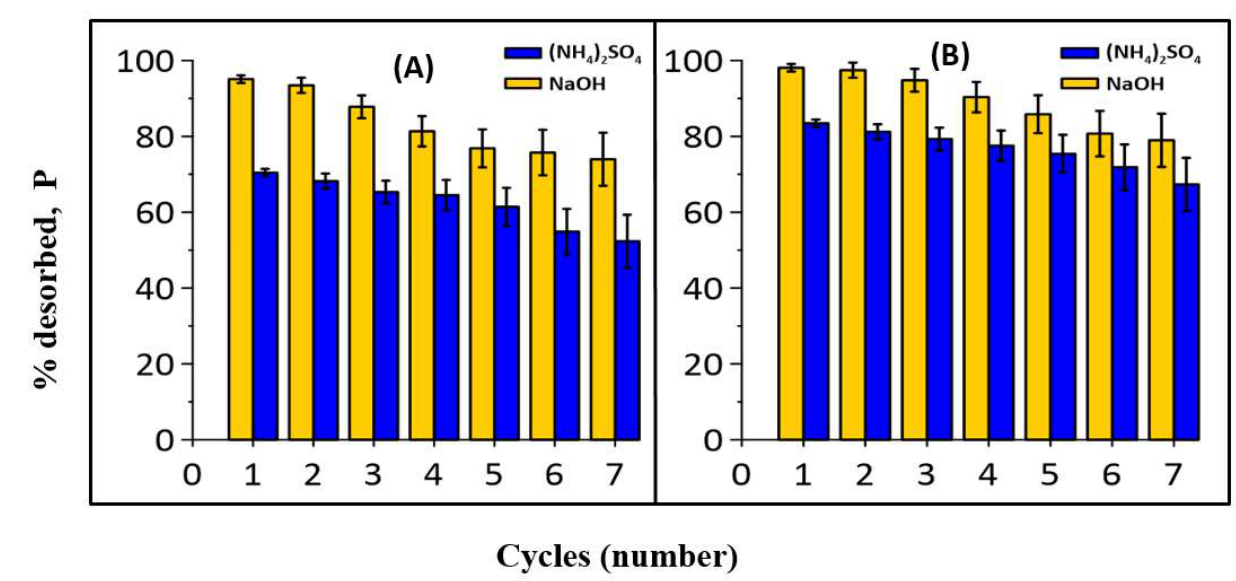
Figure 6. Desorption of P from P-loaded ( A ) Zr–FeBC, and ( B ) Fe–BC (initial P concentration was 20 mg L –1 and biochar density was 2.0 g L –1 ) (initial P concentration was 20 mg L –1 , biochar concentration was 2.0 g L –1 , at 22 ± 0.5 °C).